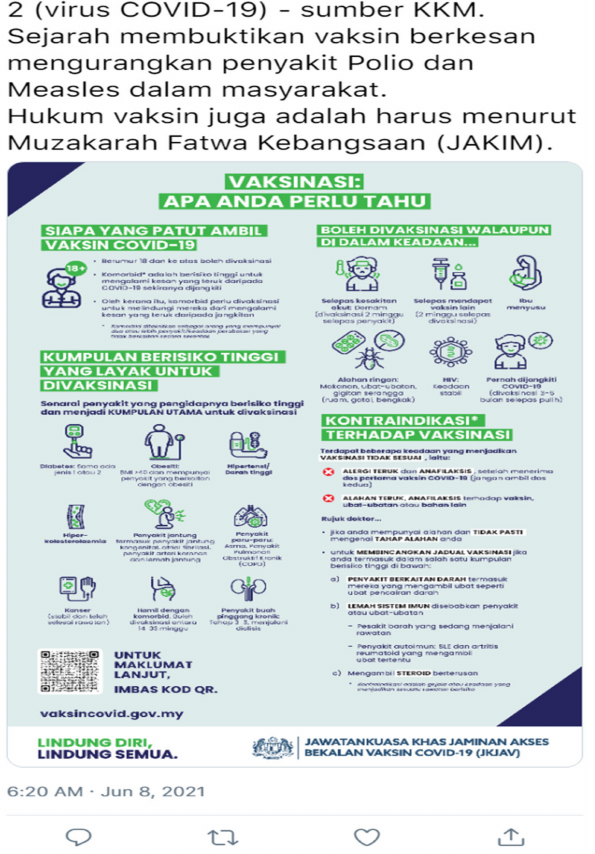
Figure 2. Scenario 1 (high information completeness and high information